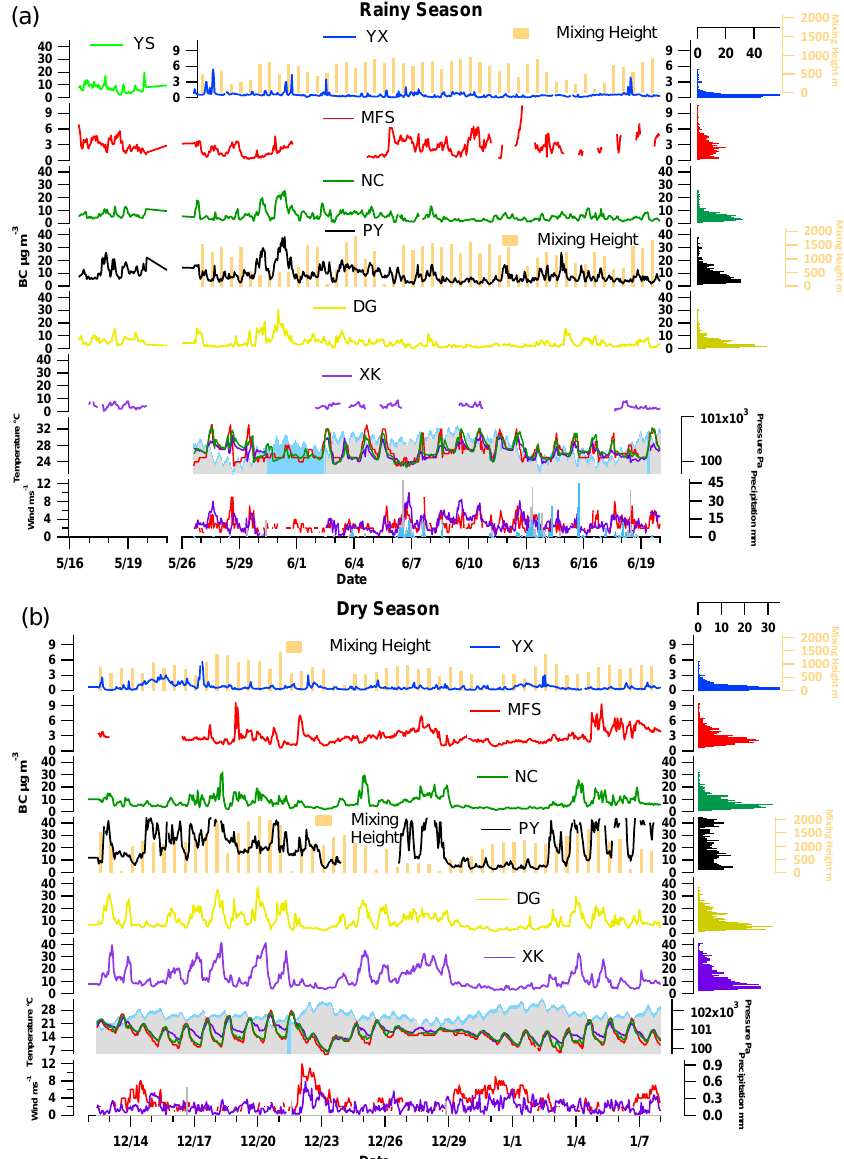
Fig. 2. Time series of BC hourly concentrations, temperature, atmospheric pressure, wind speed, and precipitation amount in the (a) rainy season sampling period and in the (b) dry season sampling period. The bar plots overlaying on the BC plots at YX and PY show the mixing height from balloon measurements. The histograms shown to the right of BC time series are the frequency distributions of BC concentrations. In the temperature time series plots, the red curve is measurements for Baiyun airport, 17km west to MFS, and is considered to represent meteorological conditions in the northern part of PRD; the green curve is for NC and the purple curve is for XK. In the station pressure plots, the grey areas represent XK and the light blue for NC. In the wind speed plots, red is for the Baiyun airport, purple for XK. In the precipitation plots, grey bars are for XK and light blue for urban